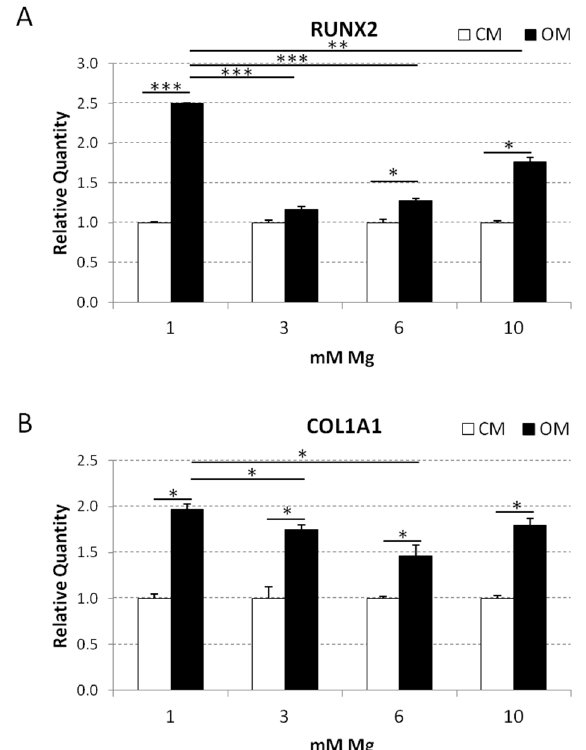
Figure 6. Effects of supra-physiological concentrations of Mg on the expression of RUNX2 and COL1A1 in bMSCs exposed to VD3. QRT-PCR was performed on RNA extracted from bMSCs cultured for four days in 1, 3, 6, and 10 mM Mg, added (OM) or not (CM) with the osteogenic cocktail. Primers designed on RUNX2 and COL1A1 sequence were used. * p < 0.05, ** p < 0.01, *** p < 0.001.